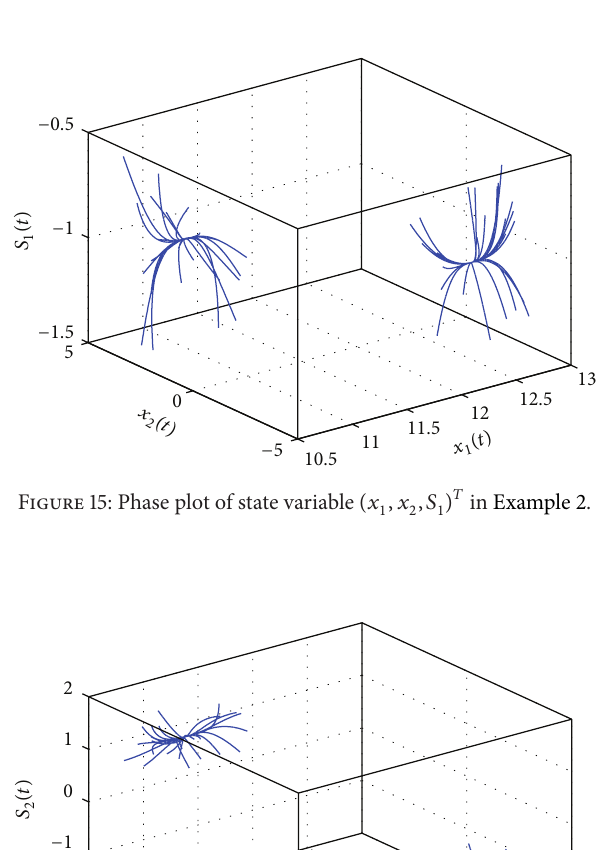
Figure 17: Transient behavior of 𝑥 1 and 𝑥 2 near the equilibrium point (59/5, −1/2, −1, 0) 𝑇 in Example